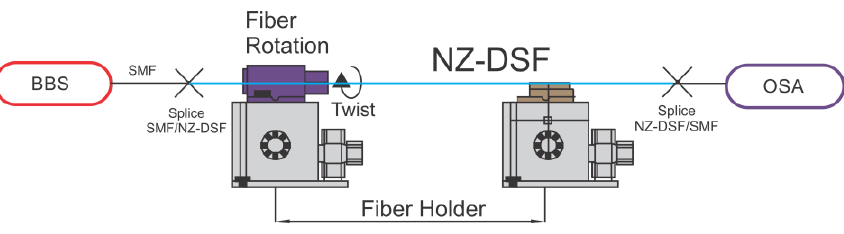
Figure 4. Experimental setup to characterized MZI.